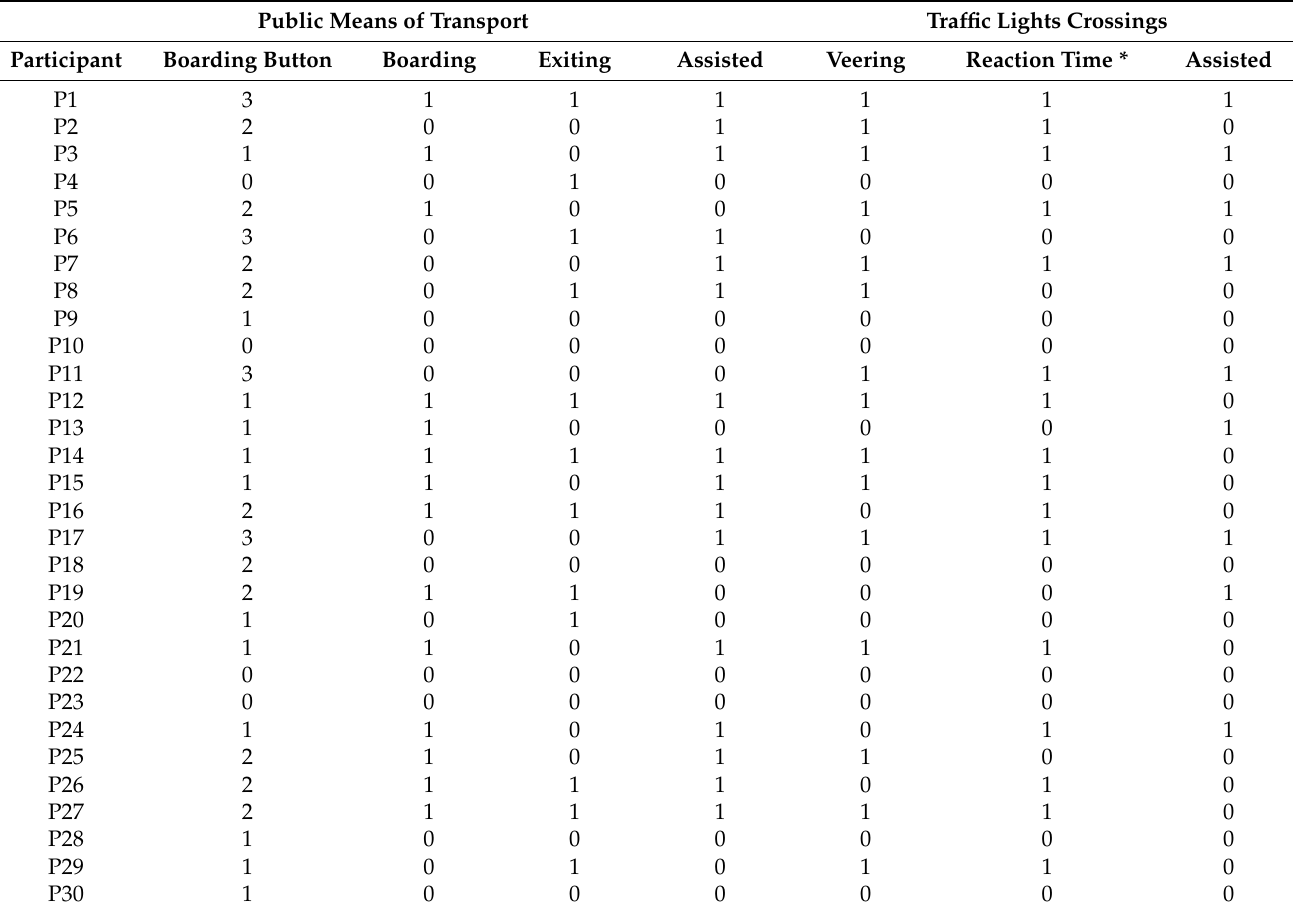
Table 4. Traffic lights crossings and public means of Transport Navigation Errors.